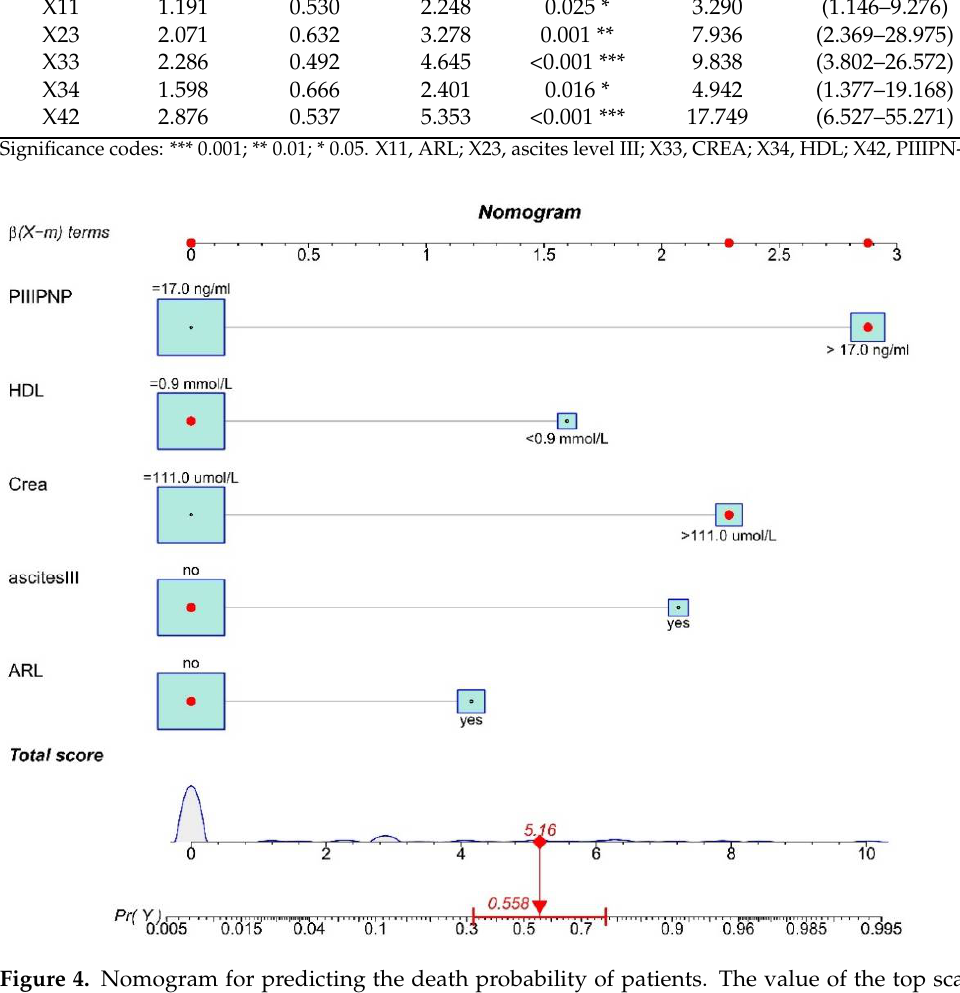
Figure 4. Nomogram for predicting the death probability of patients. The value of the top scale line is found corresponding to each independent variable, and then they are summed up. The value is projected onto the total score scale to present the corresponding death probability. PIIIPN-P, procollagen III N-terminal peptide; HDL, high-density lipoprotein; CREA, creatinine; ascites III, ascites level III; ARL, atrophy of the right